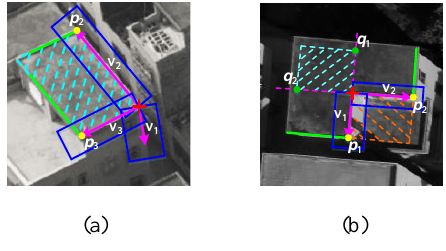
Figure 4. Support region computation for interest point in G1. (a) an example of more than two LGS vectors, and (b) an example of only two LGS vectors.